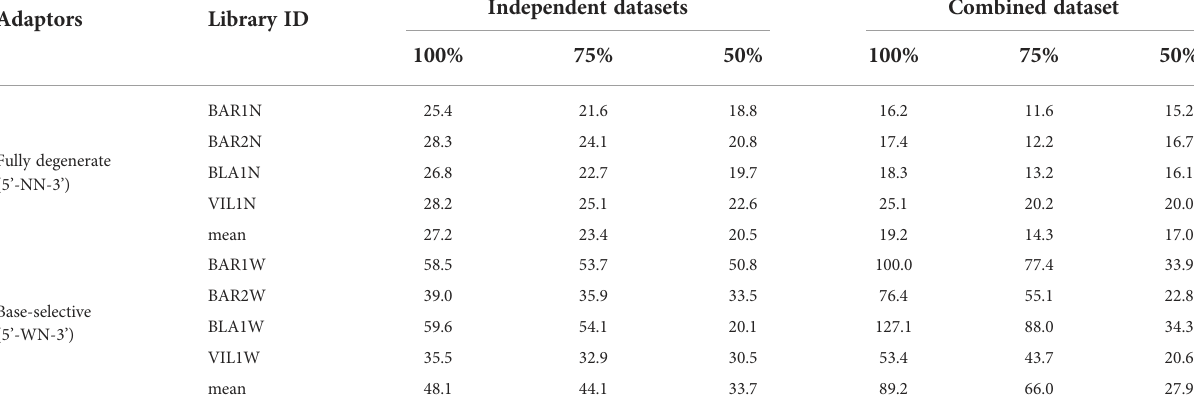
TABLE 3 Locus mean depth for each library in different datasets and fi lters.